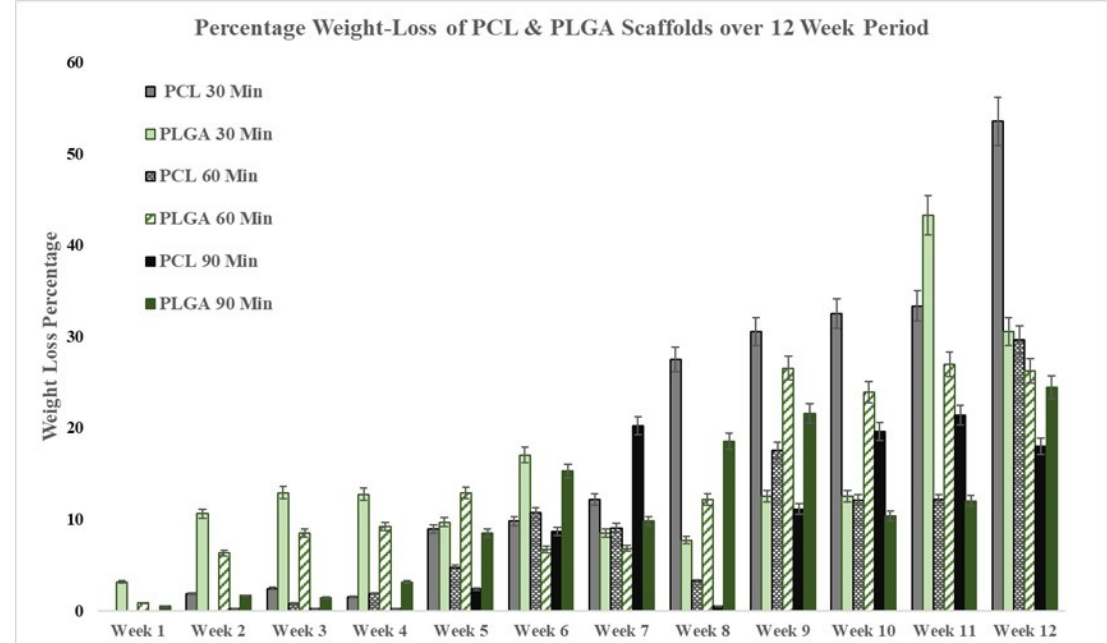
Figure 3. Degradation and weight loss percentage change of PCL and PLGA scaffolds over a 12-week period.